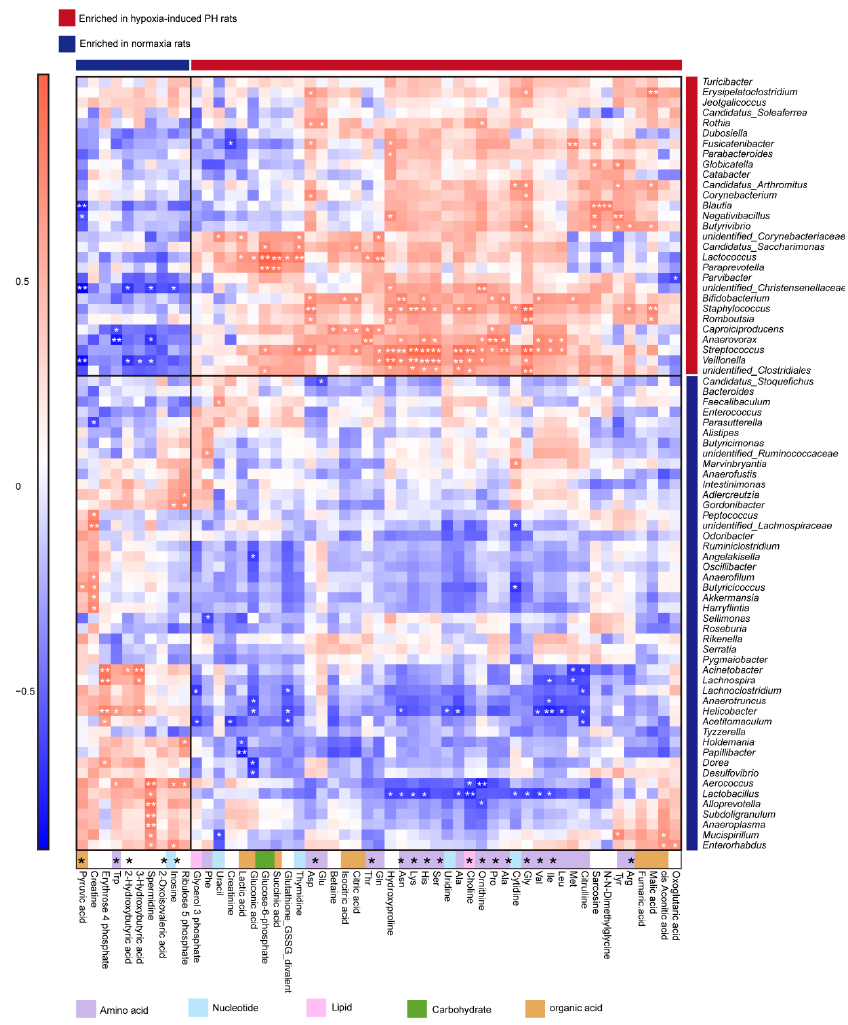
Figure 7. The correlation between gut microbiota and metabolites in normoxia- and hypoxia-induced rats. Heatmap of Spearman correlations between the bacteria whose abundances significantly changed in the Hyp ( n = 5) vs. Nor ( n = 5) groups and the metabolites with important functions and significant differences. Enrichment in either group indicated by colored bars to the right and top of the plot, blue bands represent enrichment in Nor group, red bands represent enrichment in Hyp group. Super pathway of metabolites is indicated by colored bars. Significant correlations denoted by white stars (* p < 0.05; ** p < 0.01, Student’s t test (two-sided), Benjamini–Hochberg adjustment for multiple comparisons. Exact p values are provided in Supplementary Table S3). Nor: normoxia group; Hyp (H): hypoxia-induced group.